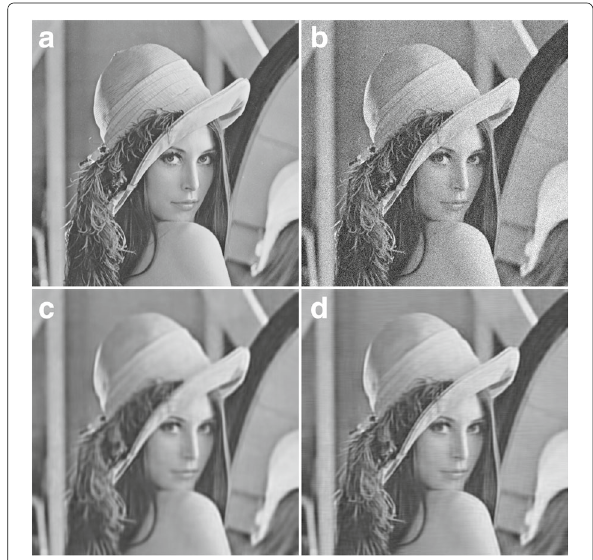
Fig. 7 Subjective assessment between the color fast profile of BM3D and the proposed method. a Original image. b Noisy image at noise level σ = 50, PSNR = 14.81, and SSIM = 0.5495. c Output using the fast profile of BM3D, PSNR = 29.29 and SSIM = 0.9724. d Output using the proposed method, PSNR = 29.57 and SSIM = 0.9740